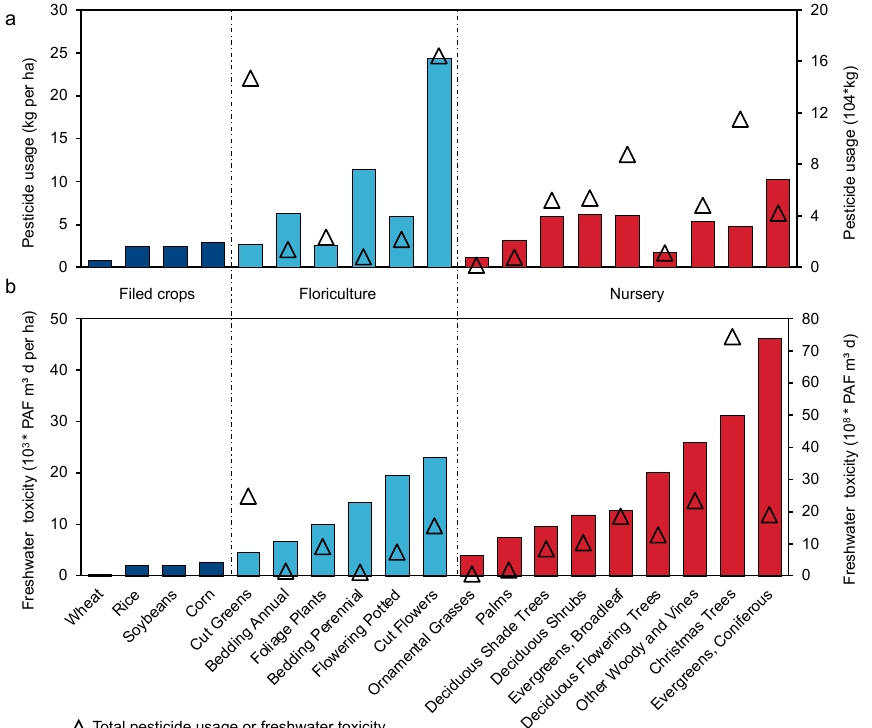
Figure 2. Pesticides usage ( a ) and ecotoxicity ( b ) across floriculture, nursery, and field crops. The bars represent the pesticide usage or ecotoxicity per ha of cropland, while the triangles represent the total pesticide usage or ecotoxicity of crops.